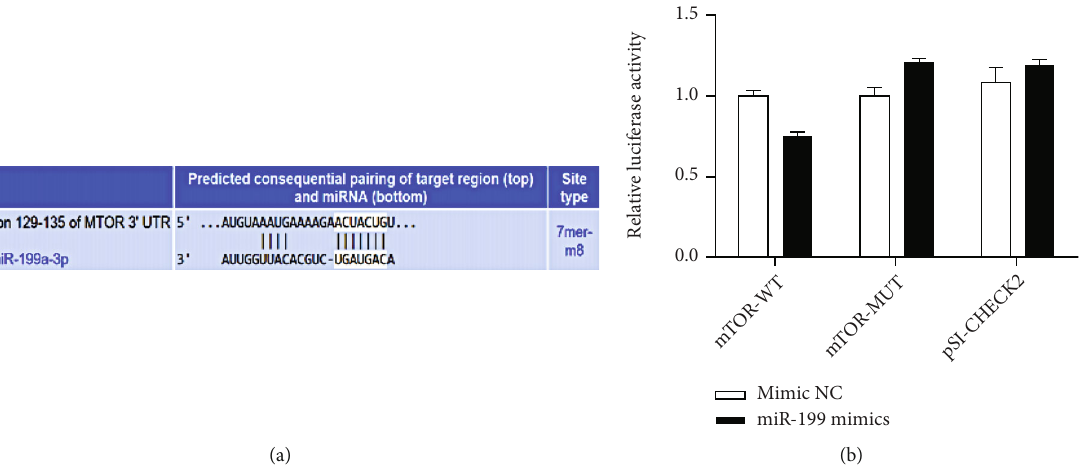
Figure 3: Binding sites between miR-199a-3p and mTOR was identi fi ed. (a) Binding site between miR-199a-3p and mTOR was predicted with bioinformatics method. (b) Binding site between miR-199a-3p and mTOR was identi fi ed. ∗ P < 0 : 05 compared to the group mimic